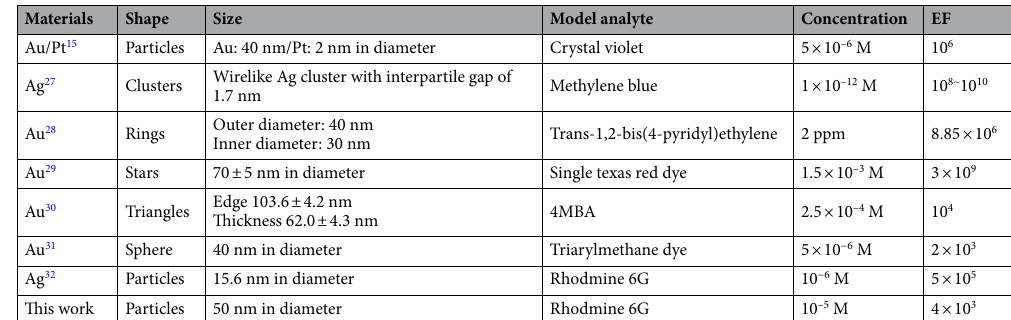
Table 1. Summary of reported SERS enhancement of colloidal nanostructures with different materials, shape, size, surface chemistry and inter-structure